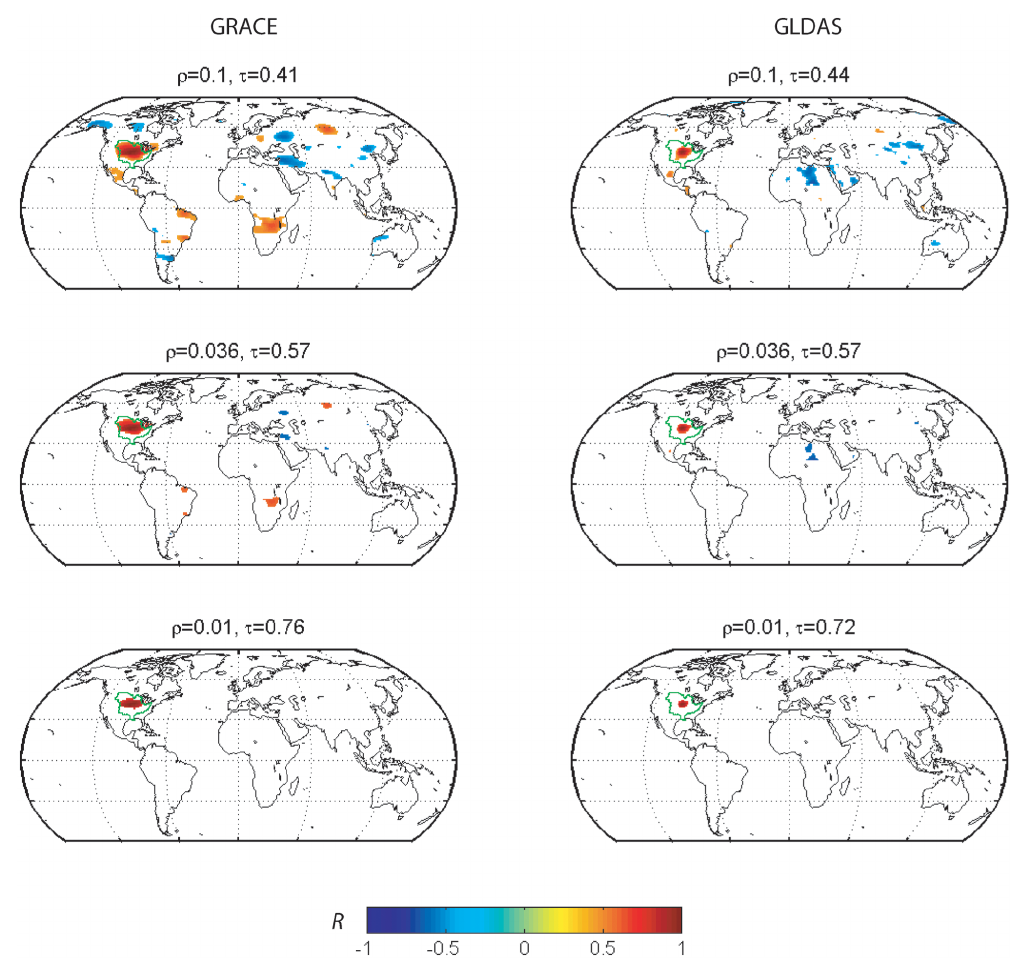
Figure 4. Sensitivity of connection patterns to cutoff threshold, demonstrated using Mississippi River basin’s centroid. Left column panels: GRACE results; right column panels: GLDAS